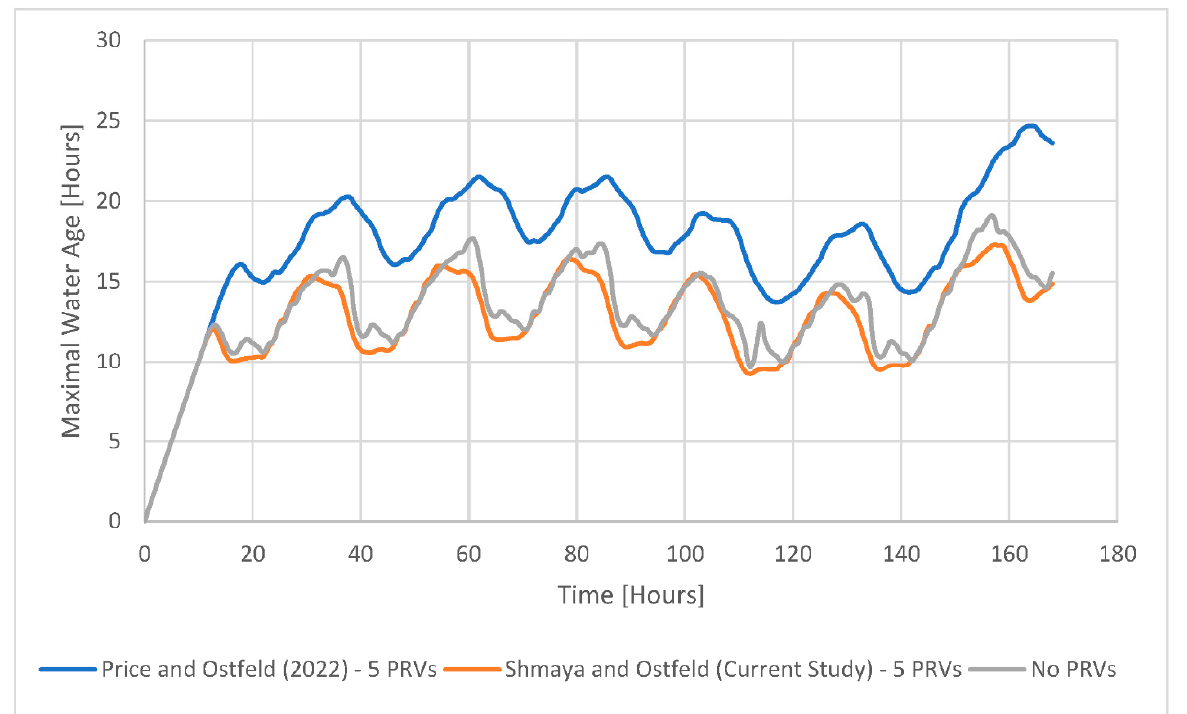
Figure 10. Maximal water age curves for the Fossolo network through the entire simulation, without any PRVs installed and after installing five PRVs using both methods.